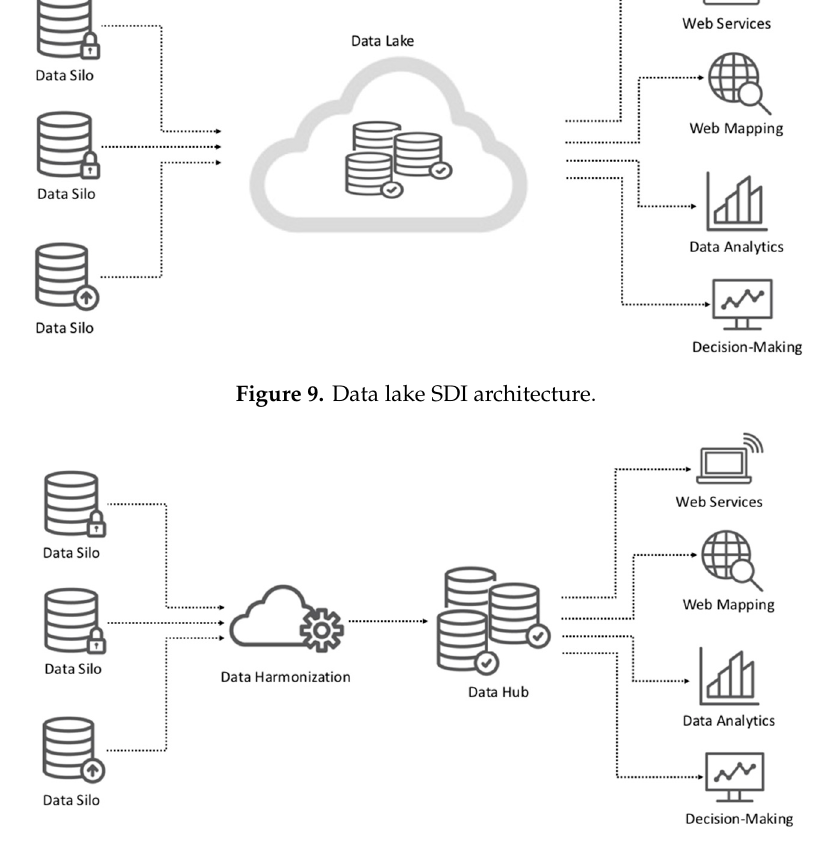
Figure 10. Data hub SDI architecture.